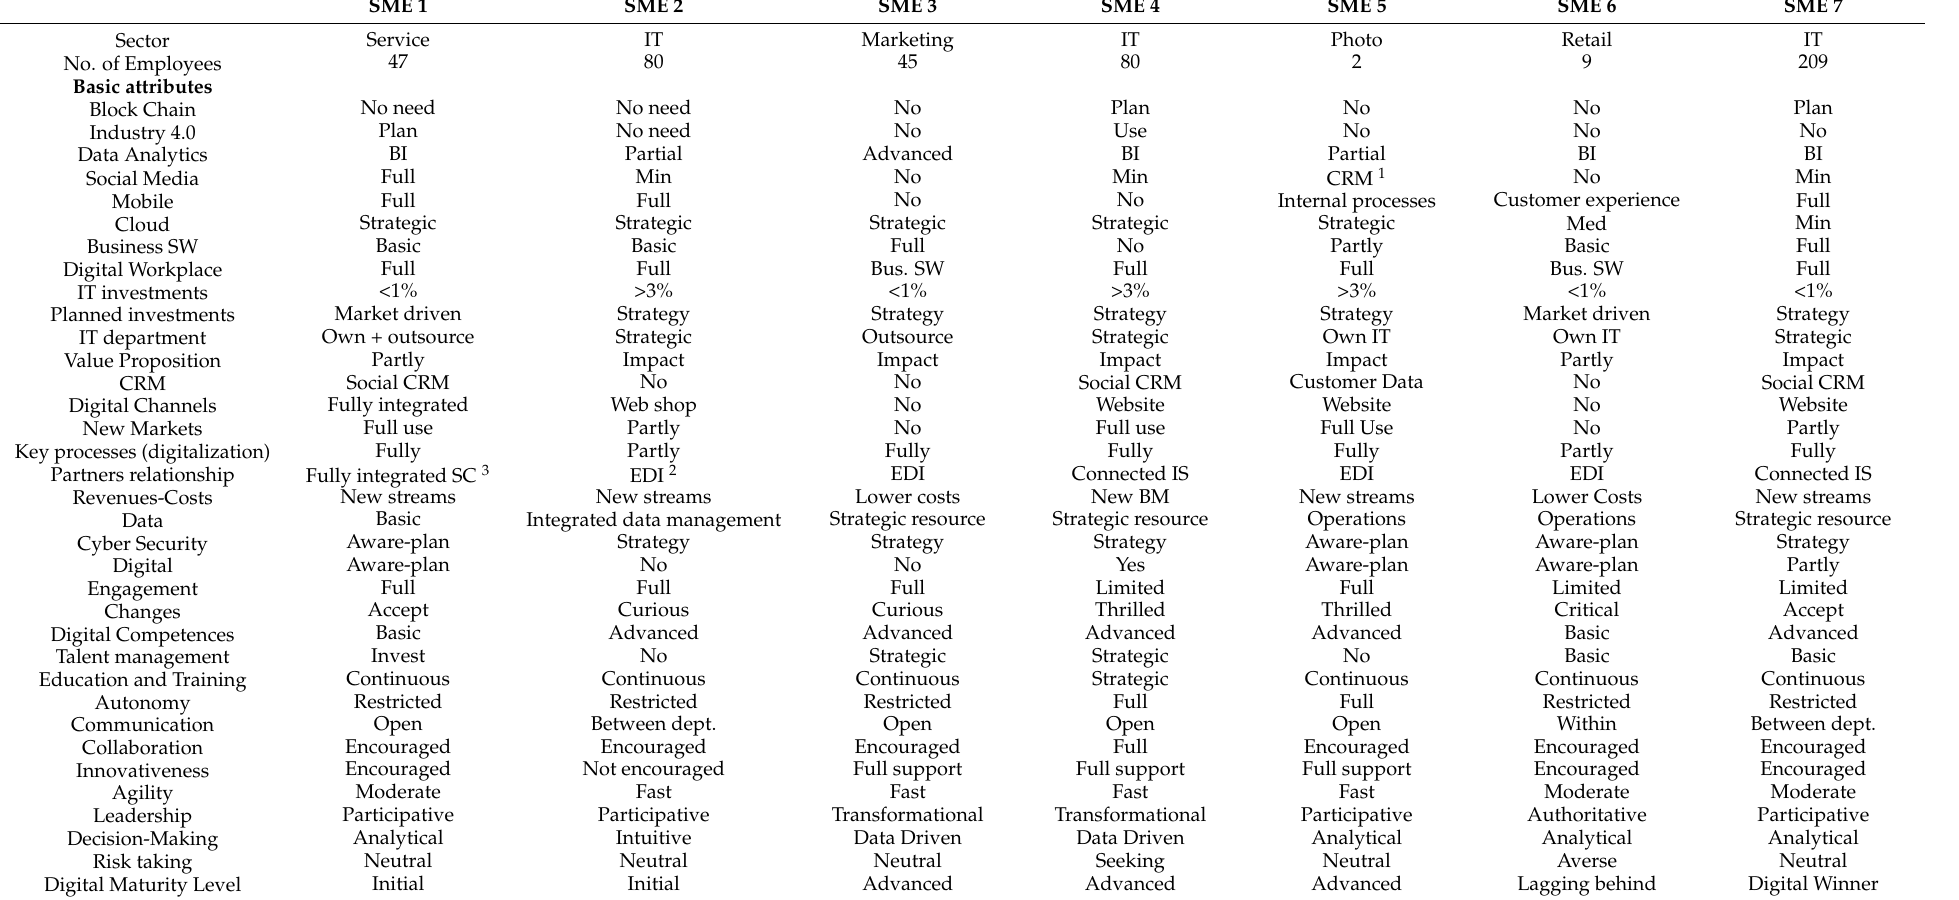
Table 2. Description of alternatives (small and medium-sized enterprises